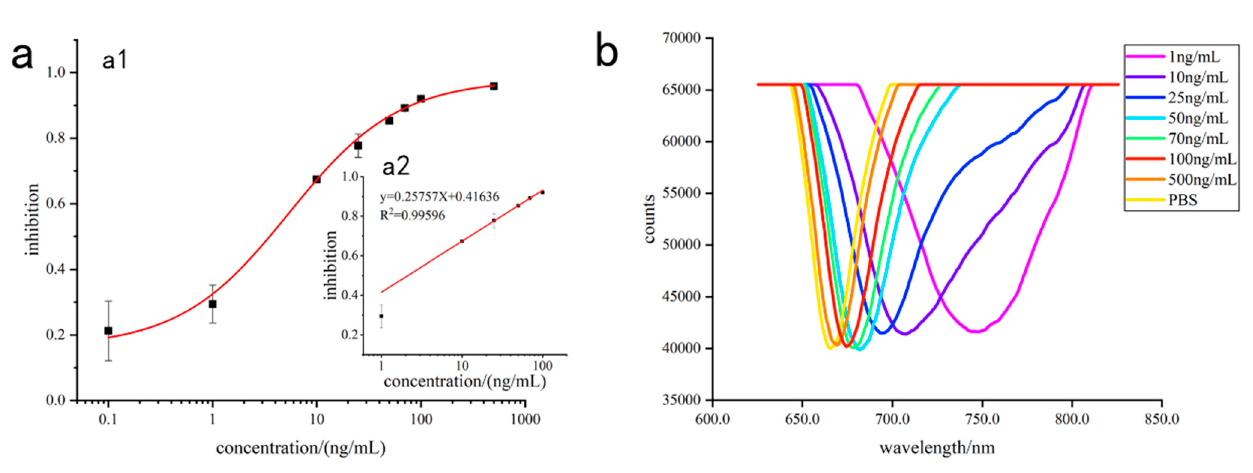
Figure 7. Direct competitive result of enhanced SPR response: direct competitive inhibition curve ( a1 ) and calibration curve of T-2 toxin detection ( a2 ); the SPR response curves of T-2 toxin at different concentrations ( b ). Table 1. Comparison of the methods for the detection of T-2 toxin.